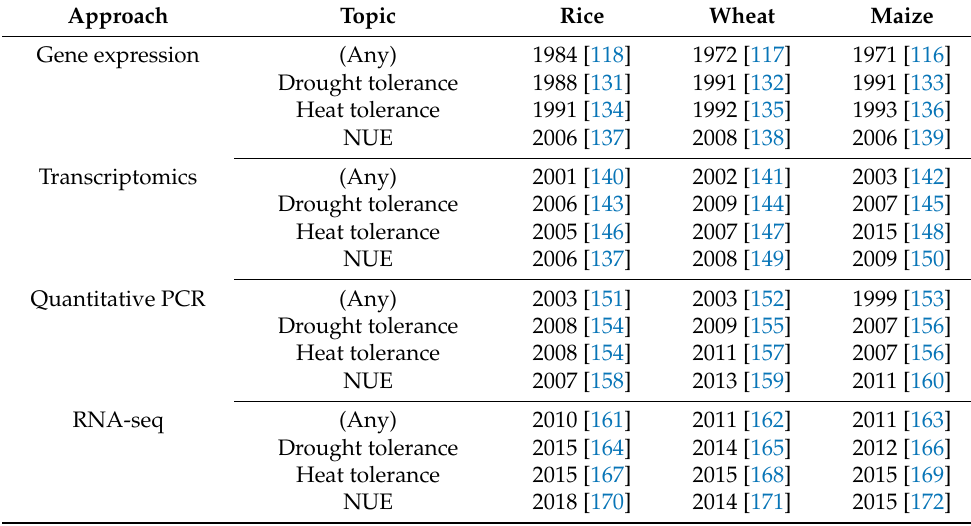
Table 2. Year and bibliographic reference of the first documented application of RNA-based ap- proaches in rice, wheat, and maize. The timing of gene expression analyses by crop and topic is also